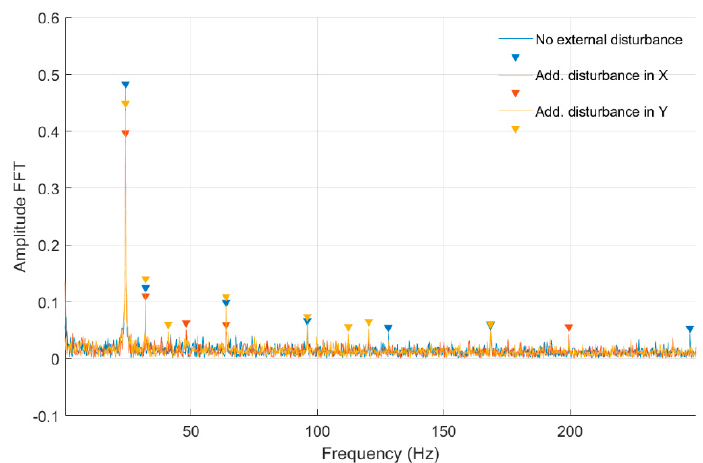
Figure 8. Fast Fourier transform (FFT) of strain-level measurement for constant motor speed equal to 25 rev/s with disturbance from the control system for a quarter-bridge configuration (Node 954).